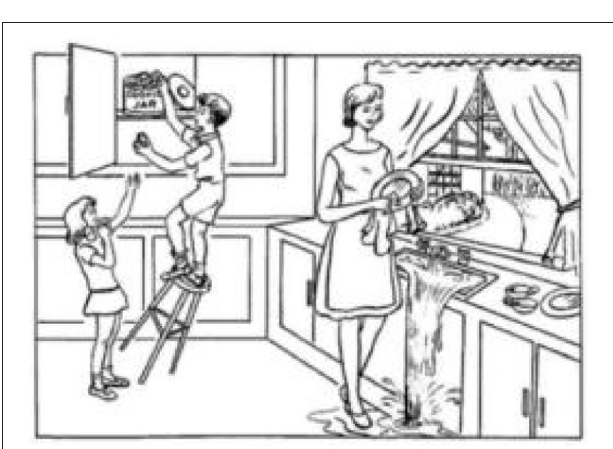
FIGURE 2 | A picture of a Boston Cookie-Theft description